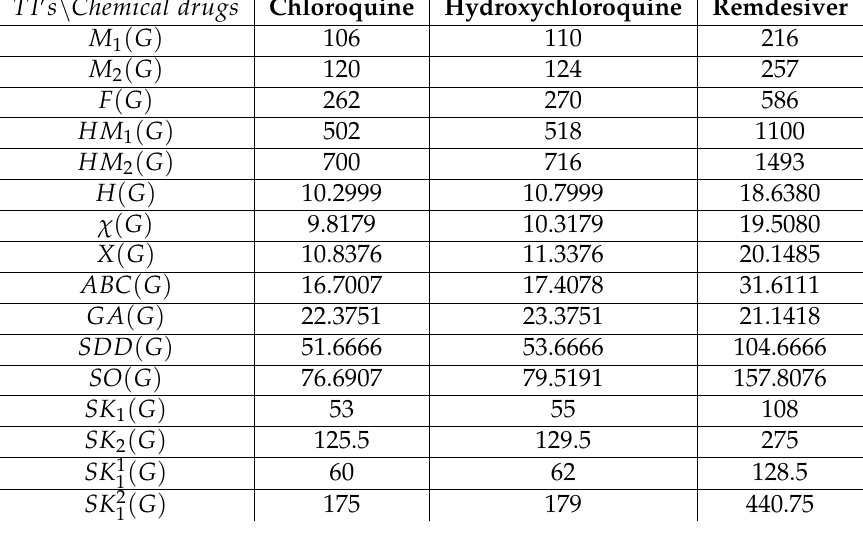
Table 3. Topological indices (TI’s) of chloroquine, hydroxychloroquine and remdesiver. TI ′ s \ Chemical